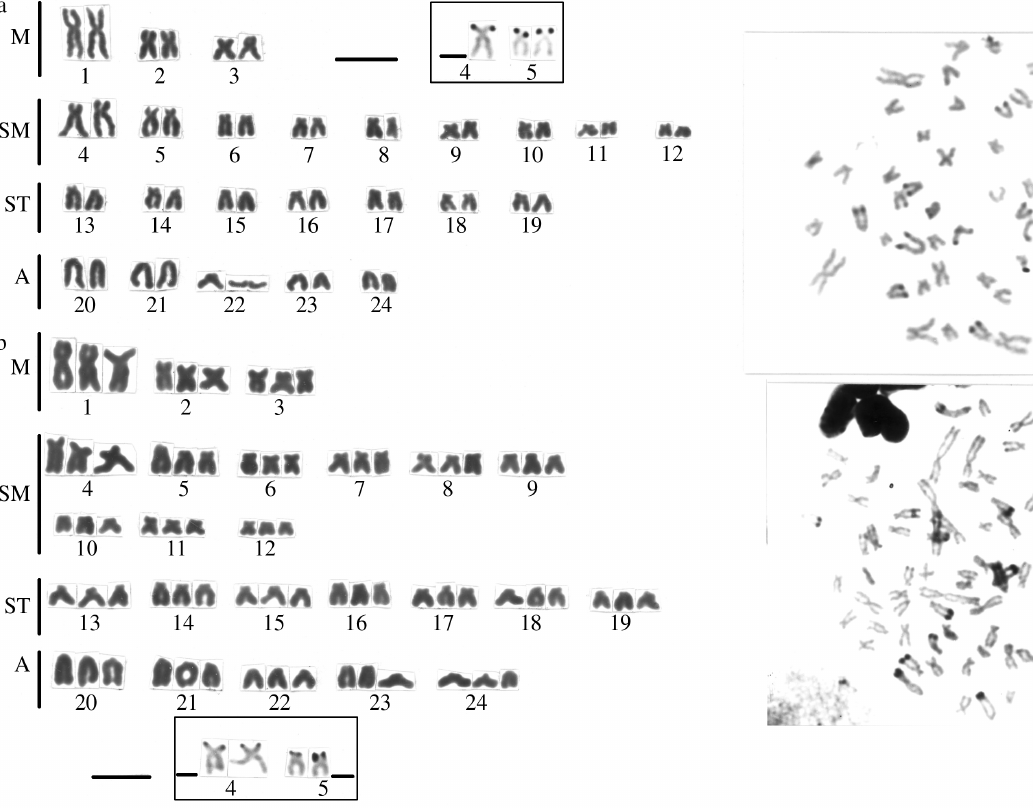
Figure3 -Diploidandtriploidkaryotypesofsinkhole2 Astyanax specimens.Theboxshowsdiploid(a)andtriploid(b)Ag-NORsandtheC-bandingpat- tern of diploid (c) and triploid (d) metaphases. Bar = 5 µ